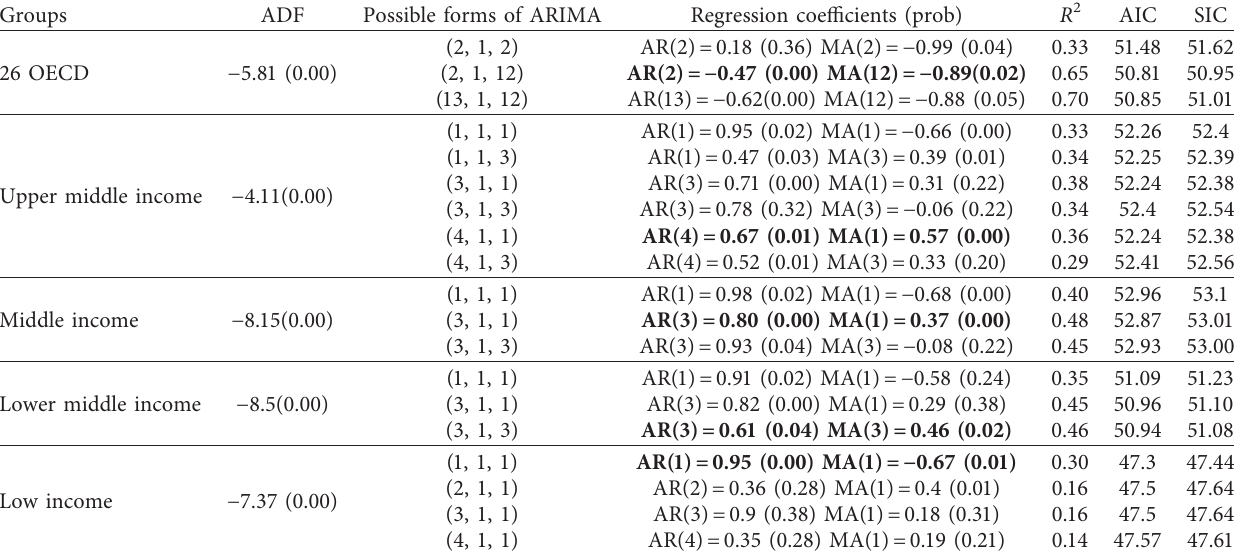
Table 3: Unit root test and ARIMA results for agricultural value addition.